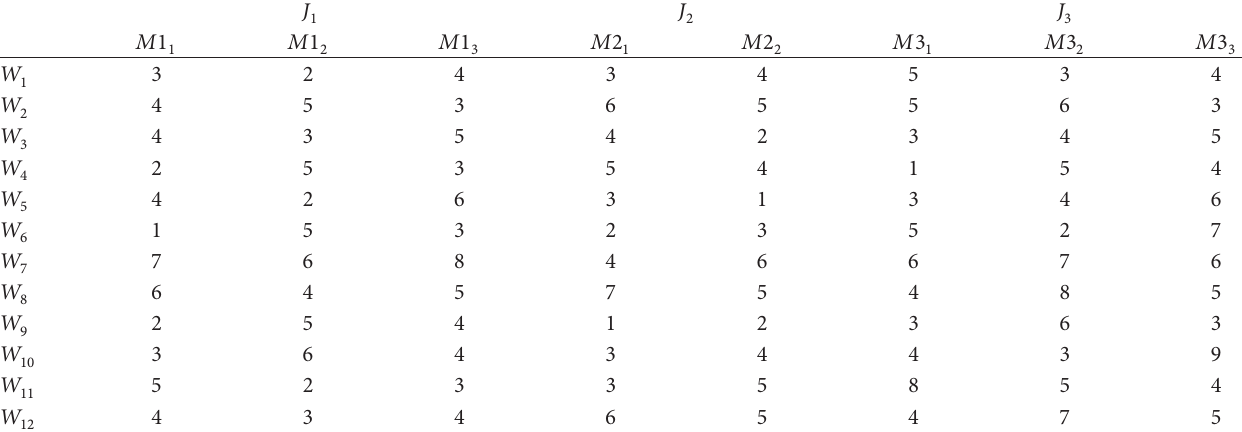
Table 4: Work time of every work group.